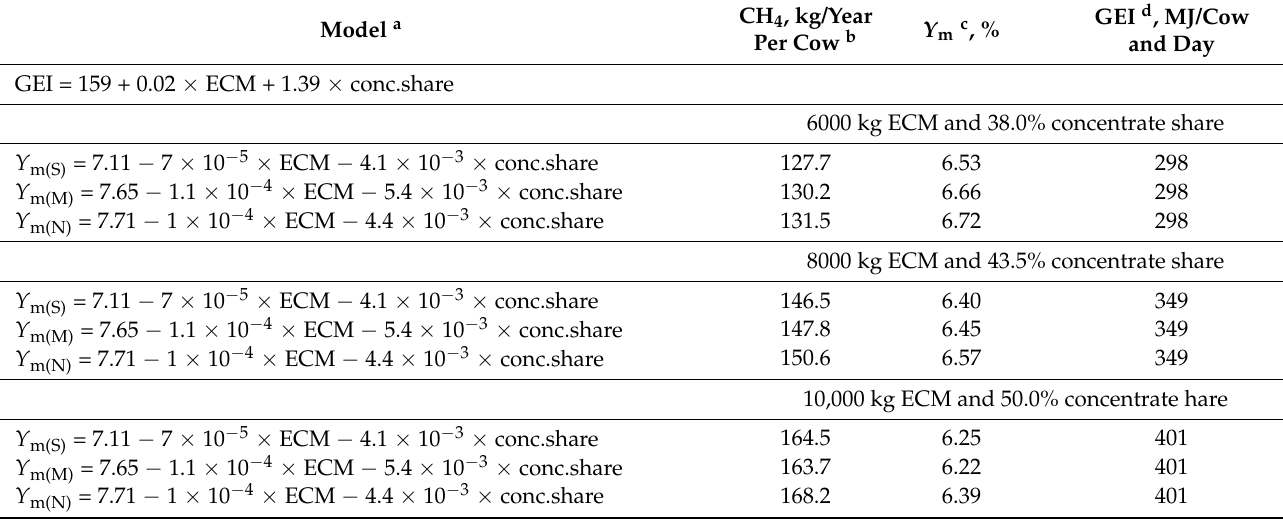
Table 5. Operational models: CH 4 emission factors (kg/year per cow), Y m and gross energy intake (GEI), estimated using selected basic models at production levels of 6000, 8000 and 10,000 kg energy corrected milk (ECM) assuming 38.0, 43.5 and 50.0% concentrate share in the rations, respectively. Model a GEI = 159 + 0.02 × ECM + 1.39 × conc.share